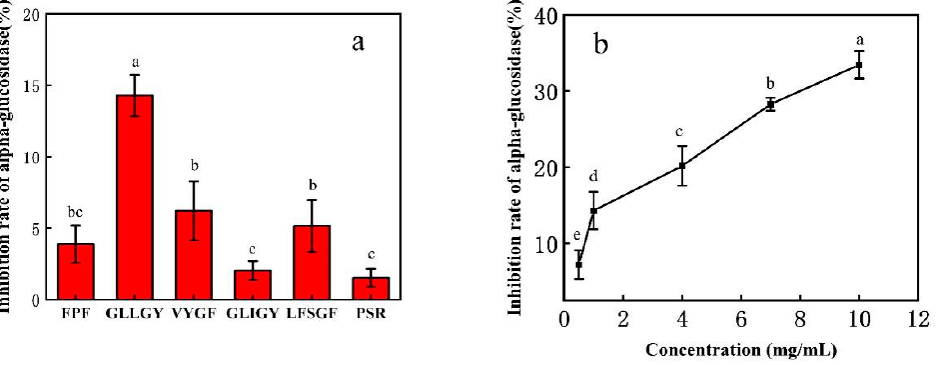
Figure 3. The α -glucosidase inhibitory activity of ( a ) peptides and ( b ) oligopeptide GLLGY.